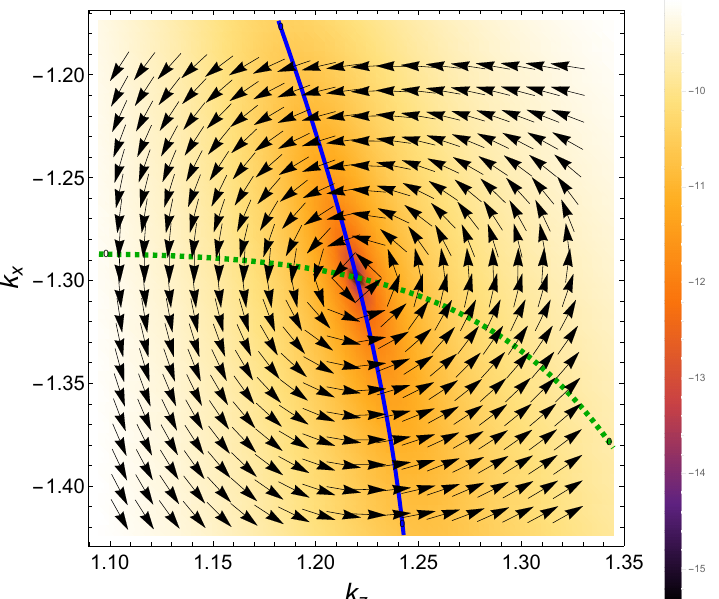
| for positron-impact ionization of hydrogen for a fixed incident Figure 7. A density plot of ln | T CB1 k ,1 s energy of 100 eV out-of-plane with a gun angle of 56.13 ◦ and a grid in the z - and x -components of ] and Im [ T CB1 ] are shown the momentum ( k z , k x ) of the ejected electron k . The nodal lines of Re [ T CB1 k ,1 s k ,1 s respectively, by the solid blue line and the dashed green line. The direction of the velocity field, ˆ v = v / | v | , is indicated by the